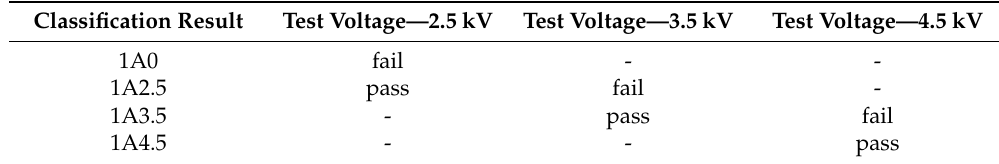
Table 3. Grading criterion for the inclined plane test.